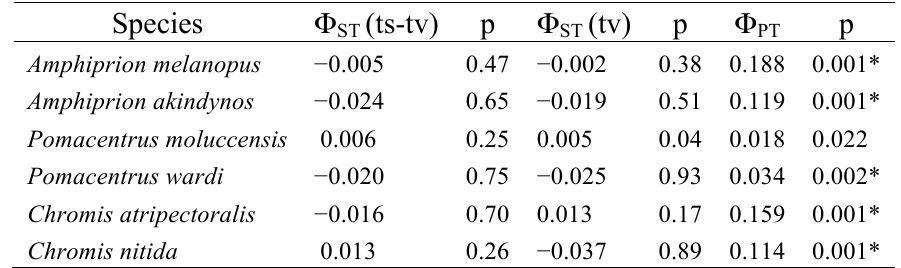
Table 2: Estimates of genetic differentiation between populations in the six species of Pomacentrid fishes. Mitochondrial fixation indices ( Φ ) based on transitions and ST transversion (ts-tv) and transversions alone (tv) and fixation index based on ISSR data ( Φ ). Statistical significance indicated by * (FDR corrected α = 0.008). PT Species Φ ST